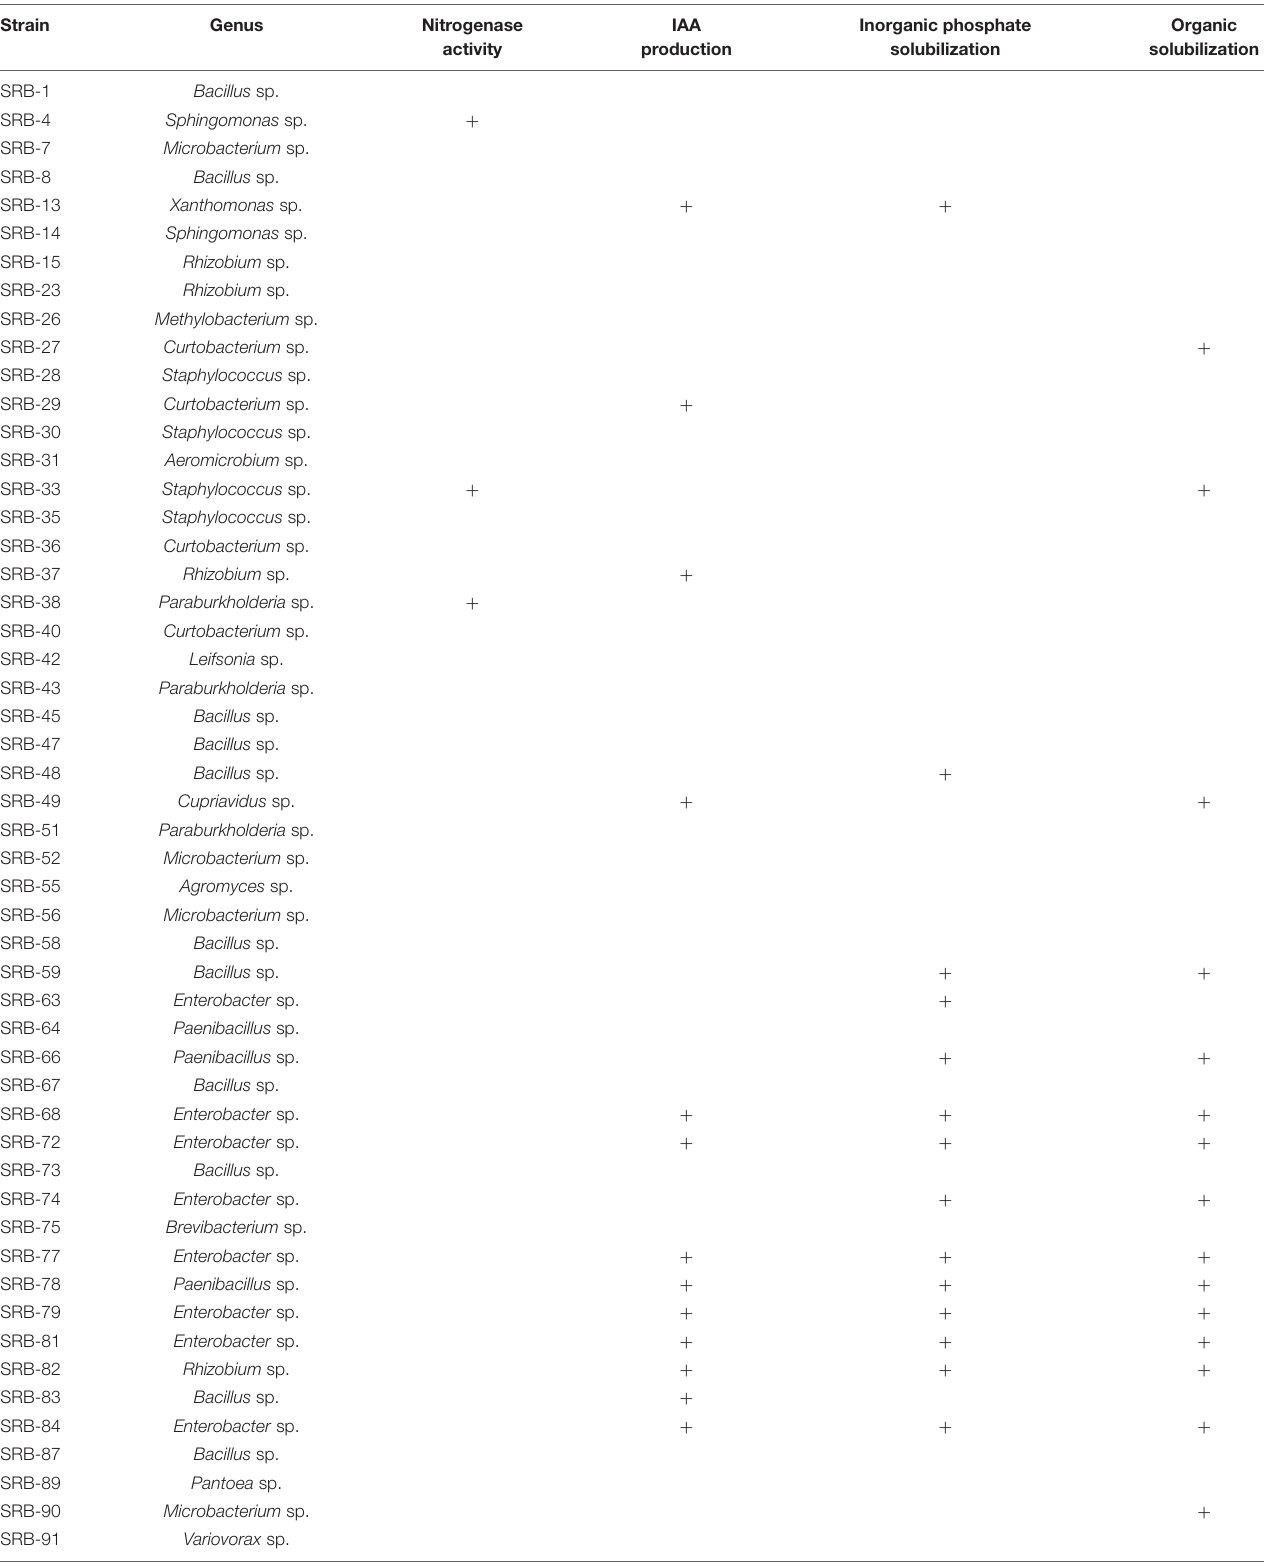
TABLE 1 | 16S rDNA sequence and functional characteristics of nitrogen-fixing bacteria in sugarcane roots. Strain Genus Nitrogenase